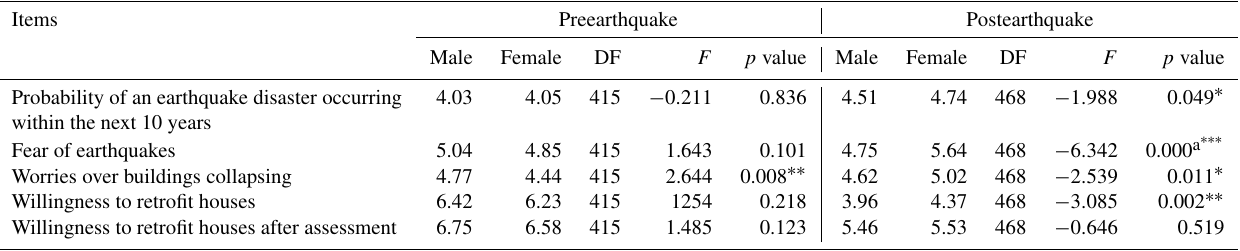
Table 3. p values and means for gender. DF denotes degrees of freedom. Items